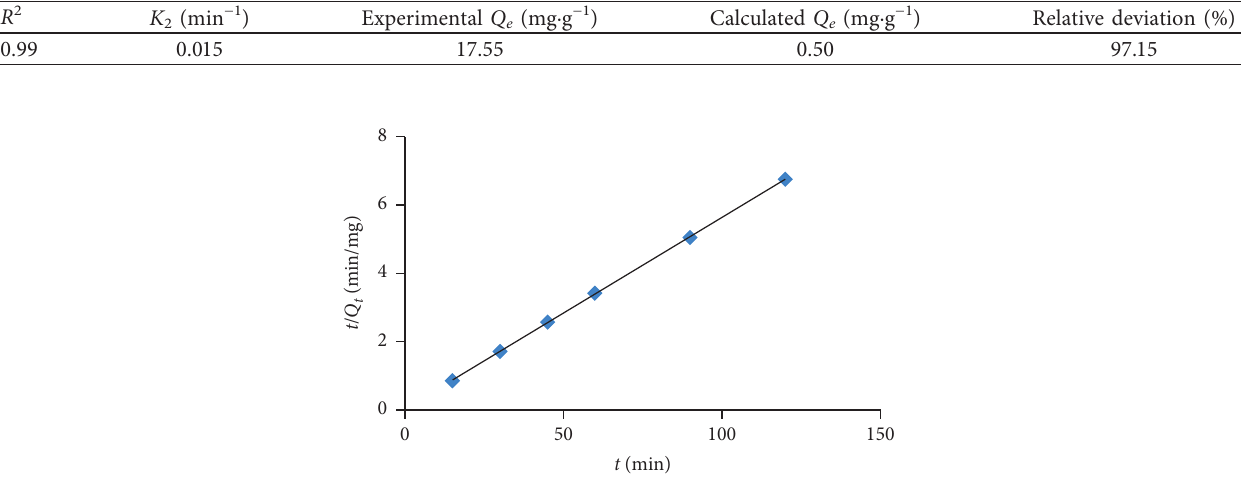
Figure 10: Pseudo-second-order model for the adsorption kinetics of phenol on the adsorbent support (equation of Ho et al.).